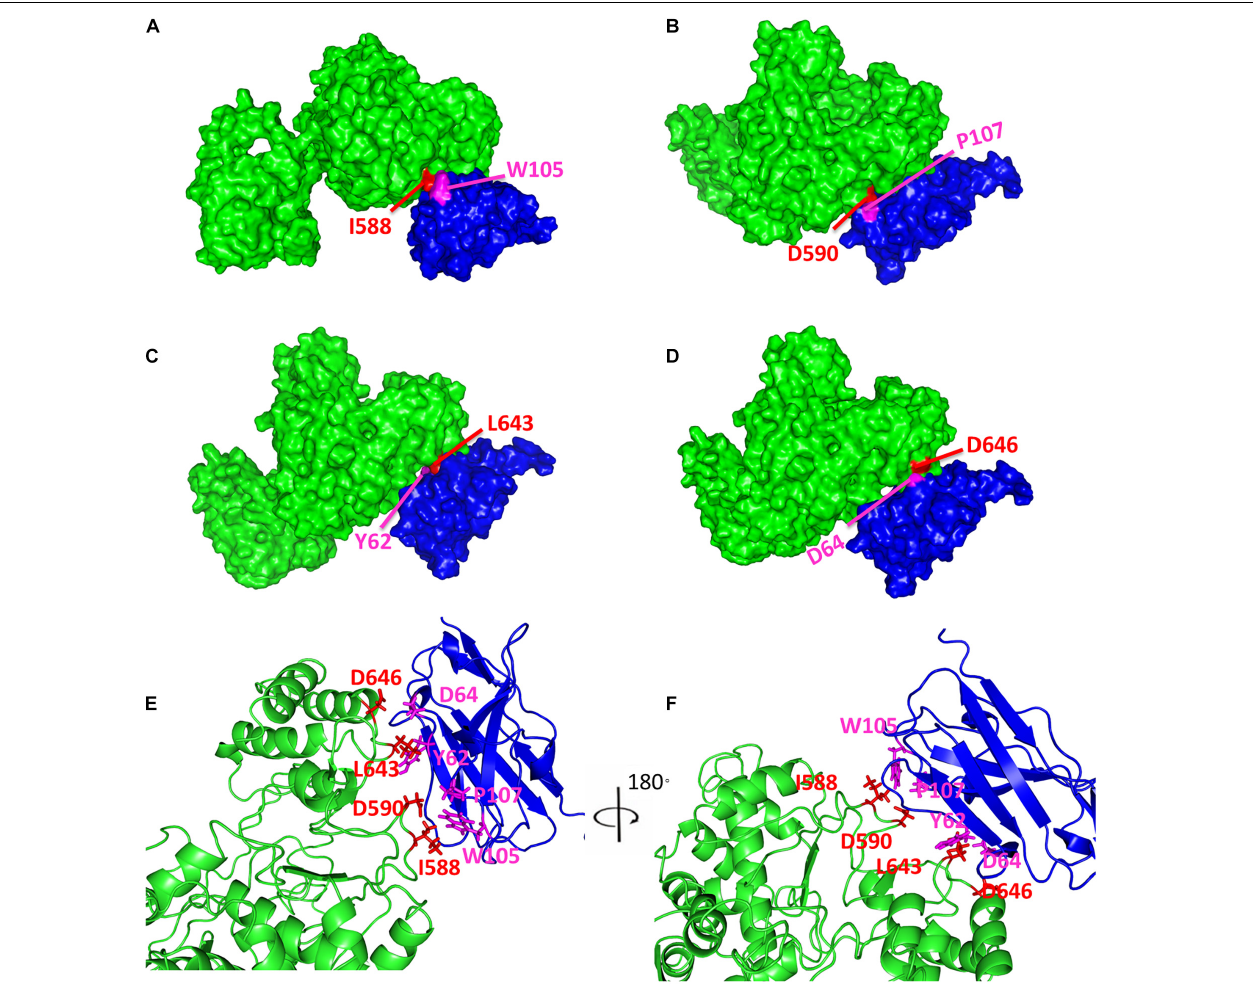
FIGURE 4 | Predicted model of Nsp9-Nb6 complex. The surface representations of Nsp9-Nb6 complex are shown in (A–D) . Nsp9 is colored in green, Nb6 is in blue, Ile588 (A) , Asp590 (B) , Leu643 (C) and Asp646 (D) in Nsp9 are highlighted in red, Trp105 (A) , Pro107 (B) , Tyr62 (C) and Asp64 (D) in Nb6 are highlighted in magentas. (E,F) The predicted complex of Nsp9 and Nb6 are shown in cartoon diagrams.